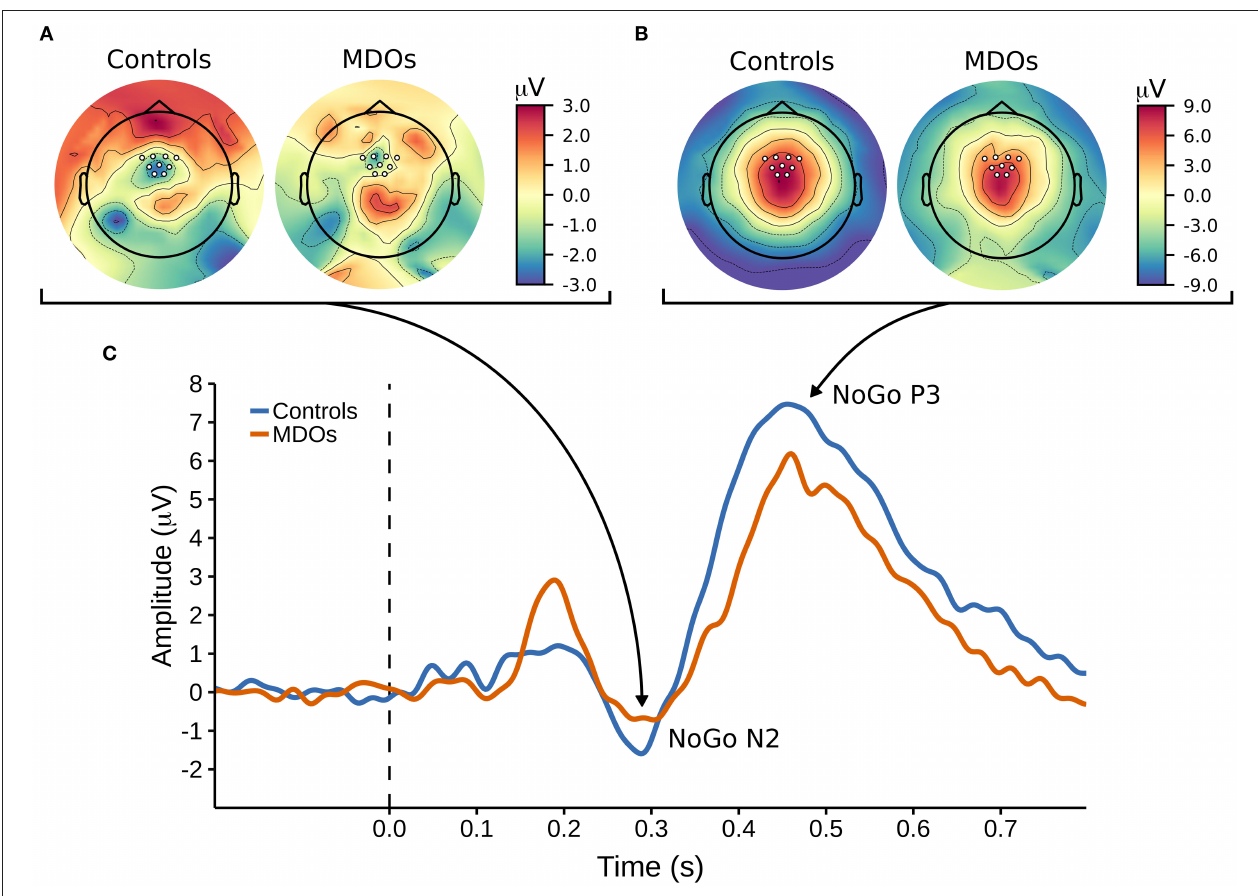
FIGURE 3 | (A,B) Topographic plots showing the cortical distribution of amplitude at (A) 290ms post-stimuli and (B) 450ms post-stimulim, with white markers indicating the locations of the nine electrodes used to create a frontocentral region of interest. (C) The NoGo ERP waveform, with arrows pointing at corresponding topographic timepoints for the NoGo N2 and NoGo P3 components. MDOs, mentally disordered